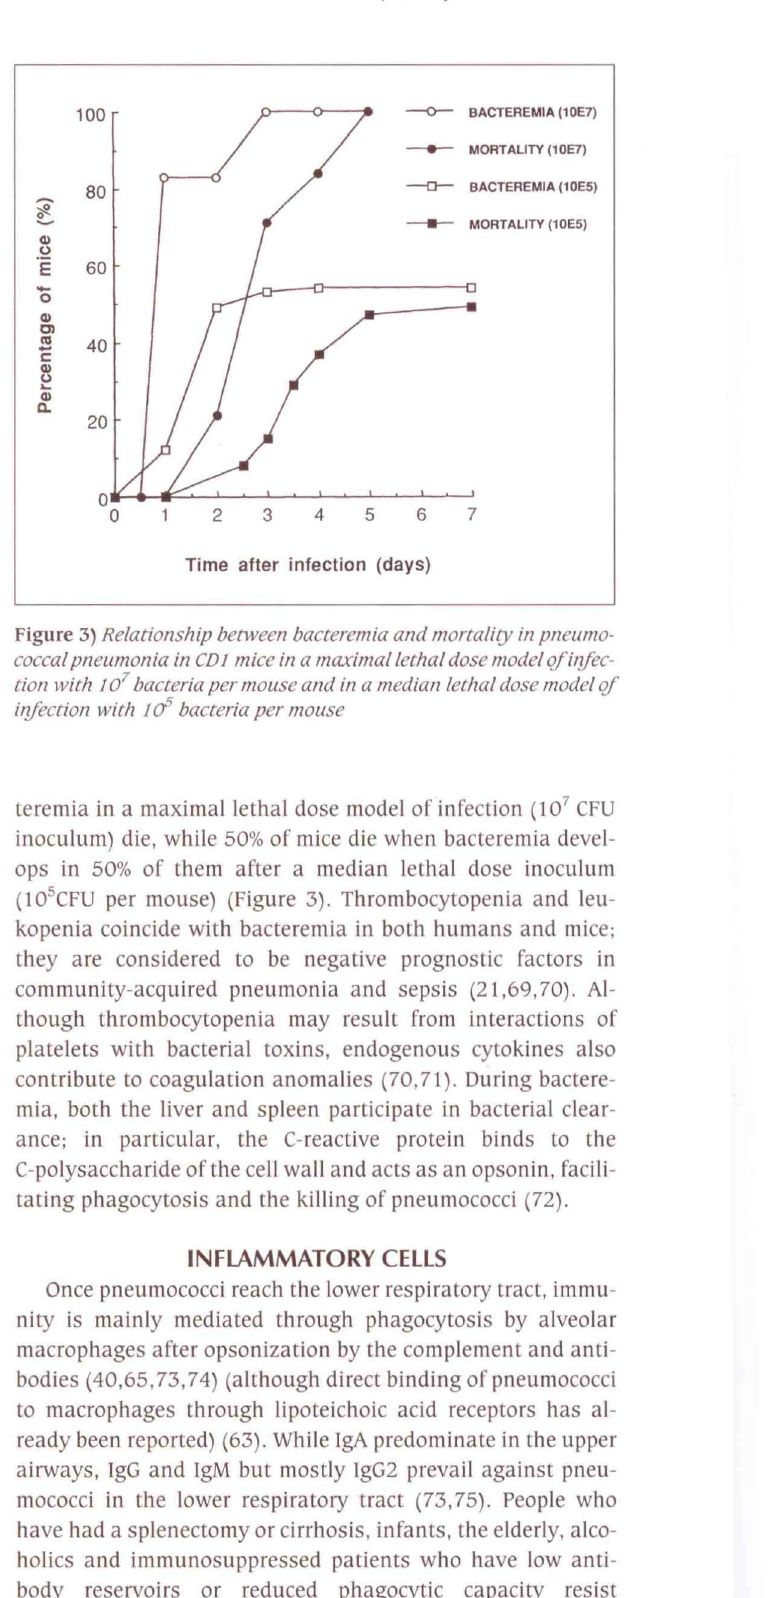
teremia in a maximal lethal dose model of infection (10 7 CFU inoculum) die, while 50% of mice die when bacteremia devel ops in 50% of them after a median lethal dose inoculum ( 10 5 CFU per mouse) (Figure 3). Thrombocytopenia and leu kopenia coincide with bacteremia in both humans and mice; they are considered to be negative prognostic factors in community-acquired pneumonia and sepsis (21 ,69,70). Al though thrombocytopenia may result from interactions of platelets with bacterial toxins, endogenous cytokines also contribute to coagulation anomalies (70,71). During bactere mia, both the liver and spleen participate in bacterial clear ance; in particular, the C-reactive protein binds to the C-polysaccharide of the cell wall and acts as an opsonin, facili tating phagocytosis and the killing of pneumococci